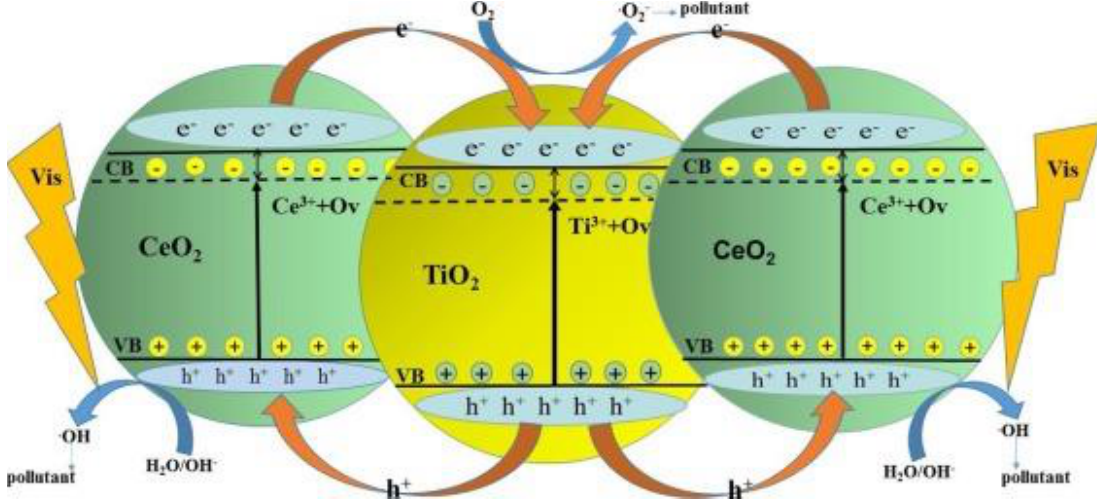
Figure 16. Visible-light-driven photocatalytic mechanism for Ti 3+ –TiO 2 /Ce 3+ -CeO 2 nanosheet heterojunctions. Reproduced from [148] . Copyright (2017), Elsevier